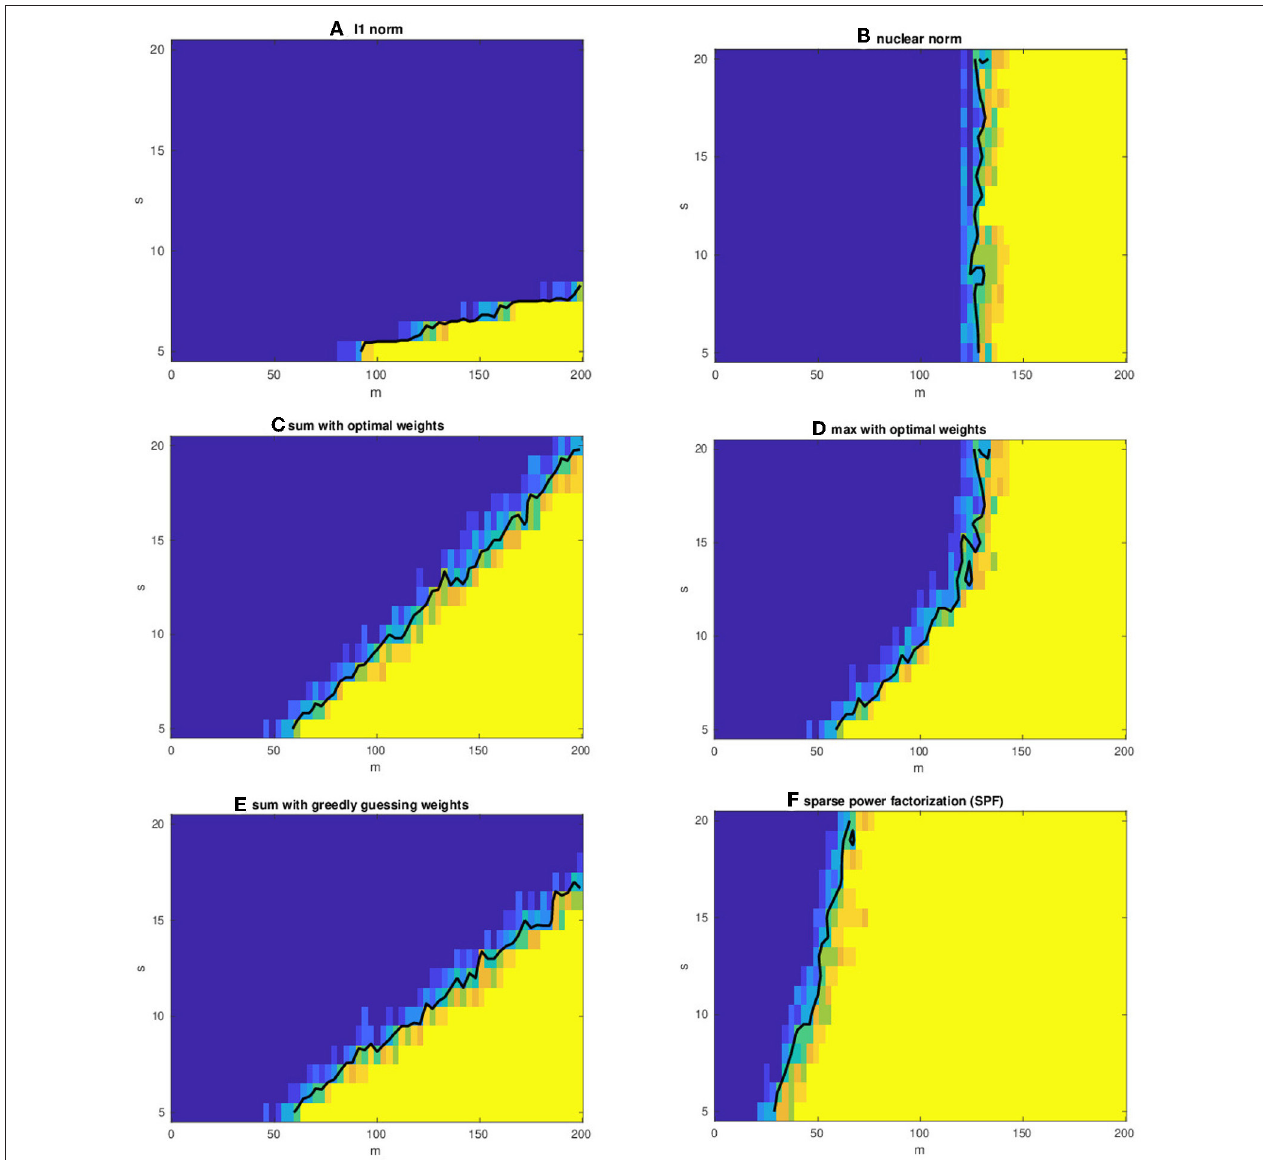
FIGURE 2 | Phase transitions for convex recovery using the ℓ 1 –norm (A) , nuclear norm (B) , the max-norm (D) , and the sum-norm (C) with optimal X 0 -dependent weights as regularizers. Furthermore, guessing weights in a greedy fashion for the sum-norm using is shown (E) and non-convex recovery using sparse power factorization (SPF) from Lee et al. [22] is in (F) . The color indicates the recovery rate with blue encoding 0 and yellow encoding